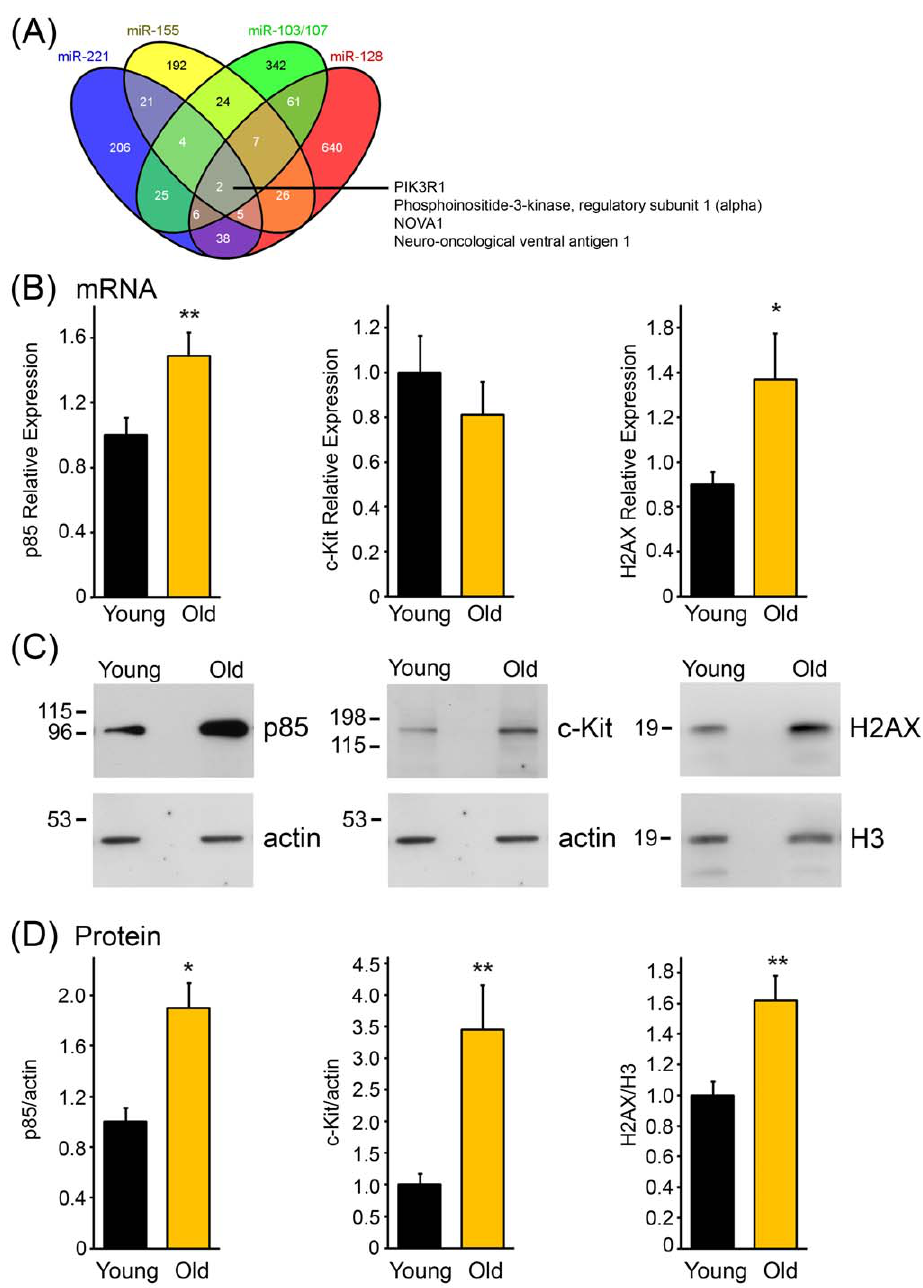
Figure 4. Putative target validation of miRNAs downregulated by age. (A) A Venn diagram showing the overlap between predicted targets of cancer-related miRNAs that were found to be downregulated in older participants. All cancer-related miRNAs have in common the predicted targets PIK3R1 and NOVA1. (B) Relative mRNA expression of PI3K, c-Kit and H2AX from 14 young and 14 old participants using real-time RT-PCR. The histograms show the normalized means 6 SEM. (C) Representative immunoblots showing protein expression of PI3K, c-Kit and H2AX in a young and old patient. Participant PBMCs were lysed and immunoblotted with anti-PI3K, anti-c-Kit and anti-H2AX antibodies and reprobed with anti-actin and anti-histone H3 antibodies as protein loading controls. The same individuals were used for each representative immunoblot in C. (D) The protein levels of PI3K, c-Kit and H2AX from PBMCs were quantified from immunoblots and normalized to the amount of actin or histone H3. The histogram represents the normalized relative mean 6 SEM from 14 young and 14 old individuals for PI3K and 10 young and 10 old individuals for c-Kit and H2AX. **P , 0.01, *P , 0.05 by Student’s t-test.